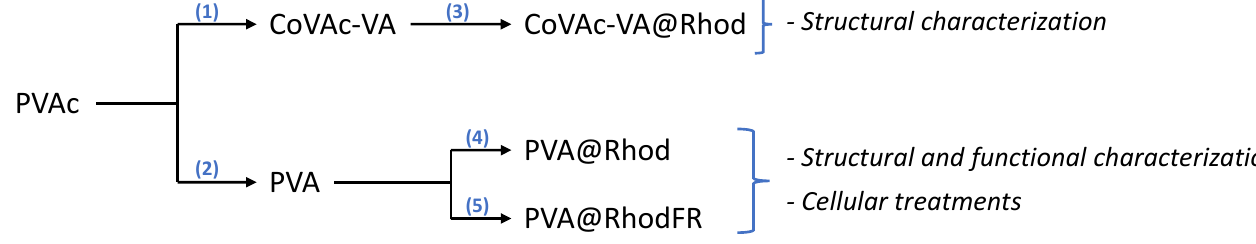
Figure 2. Representative scheme of the conjugated polymer synthesis routes: the products (1) and (2) were obtained by alkali-catalysed saponification; then, products (3), (4), and (5) were obtained by functionalisation of the related polymer backbones by catalysed esterification.